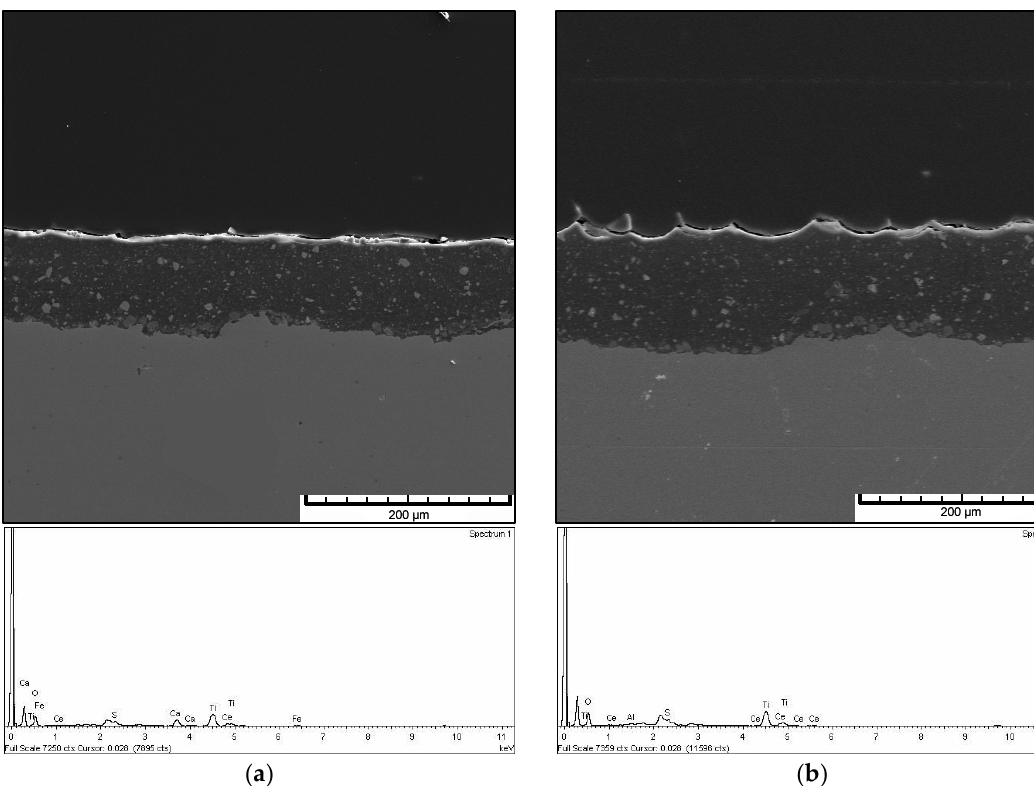
Figure 6. The SEM micrograph with EDX spectra of the powder coatings: ( a ) Sample A (epoxy-polyester), good penetration of coating into the substrate, no visible cracks, and pores, Ti pigment is dominant; ( b ) Sample C (polyester), no visible cracks and pores, finely micro-rough appearance of upper layer surface, Ti pigment is dominant.